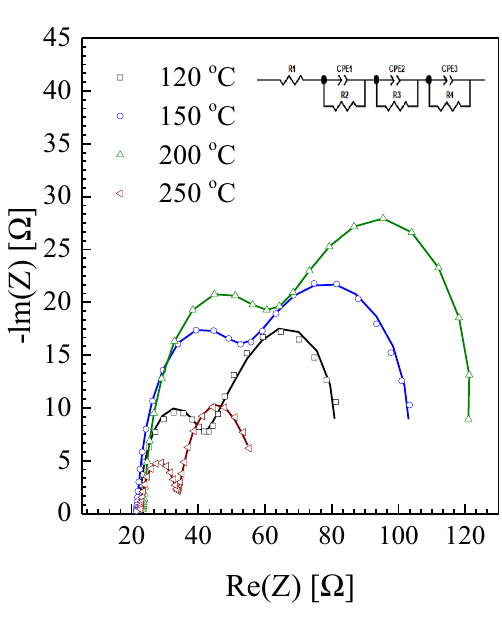
Fig. 4 FE-SEM image of TiO 2 sample synthesized at 150 °C and thermally treated at 200 °C